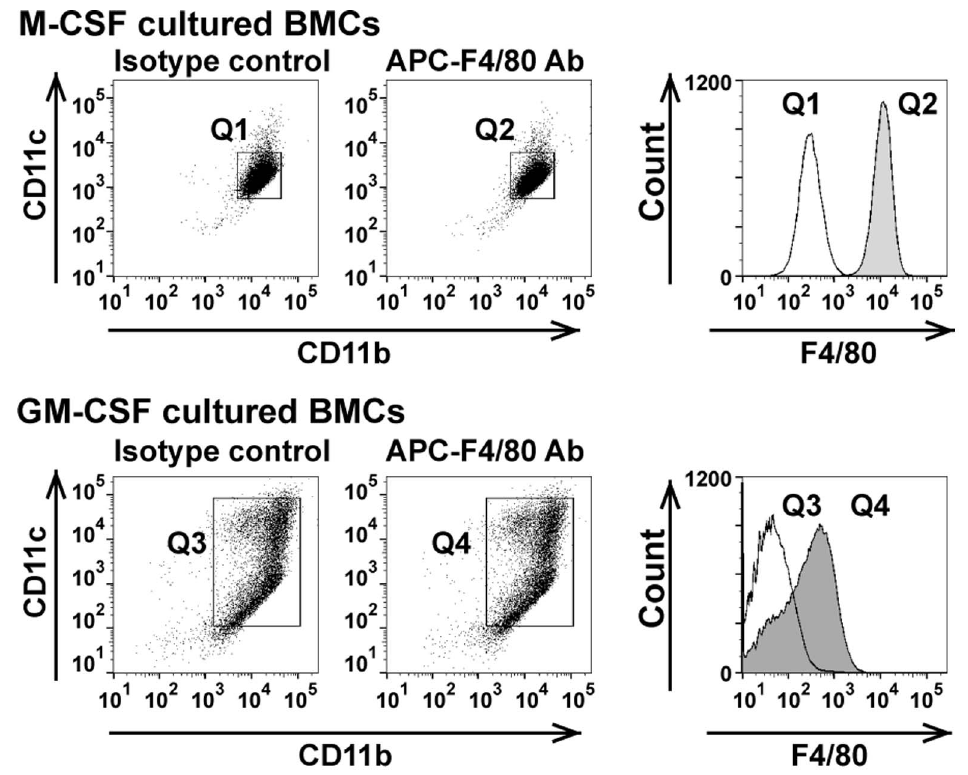
Figure 3. Flow cytometric analysis of F4/80 + macrophages from M-CSF- or GM-CSF- cultured BMCs. Data is representative of three independent experiments.